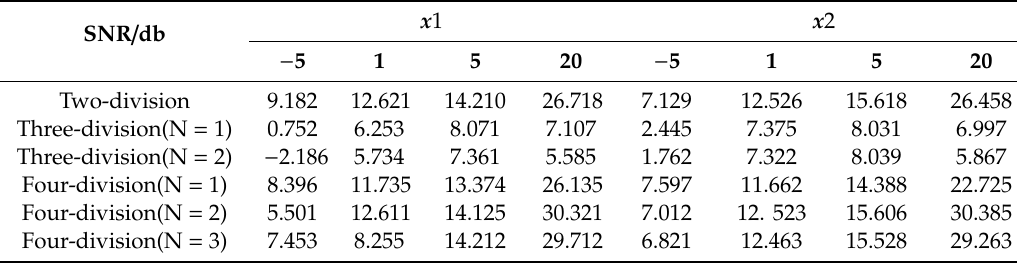
Table 1. The SNR of different noise reduction models.